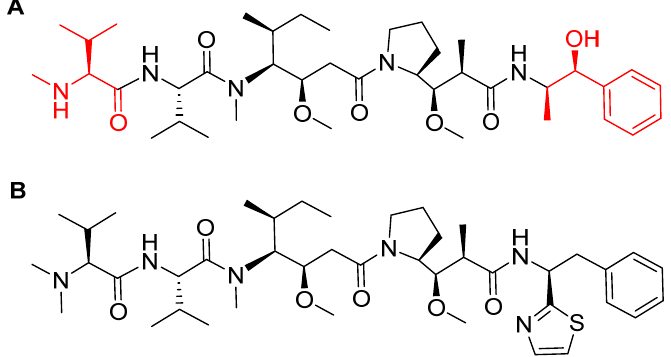
Figure 8. Chemical structure of: ( A ) Synthetic monomethyl auristatin E (MMAE) analogue; ( B ) natural dolastatin 10. Differences are shown in red [50].